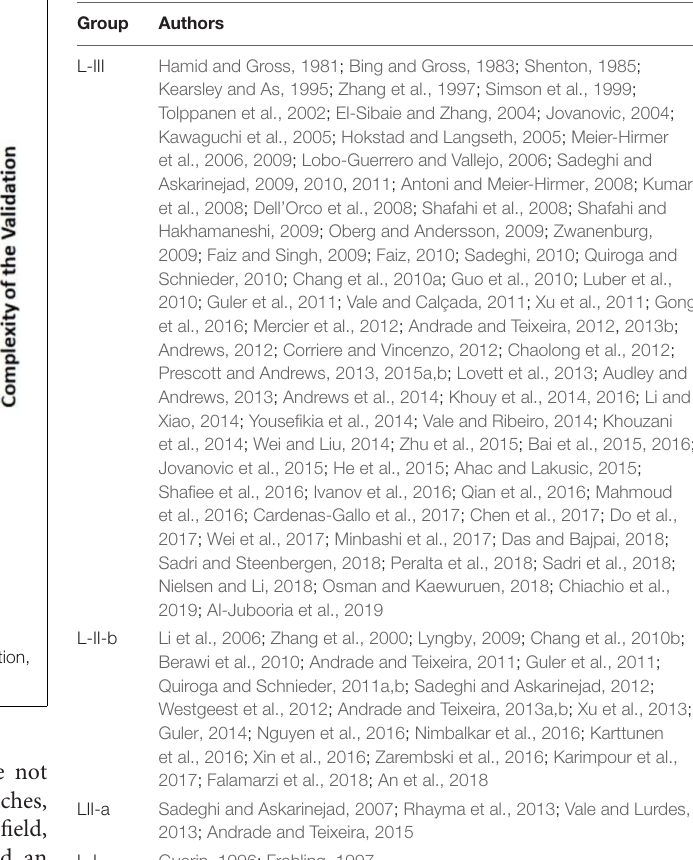
TABLE 5 | Selected primary studies and their respective